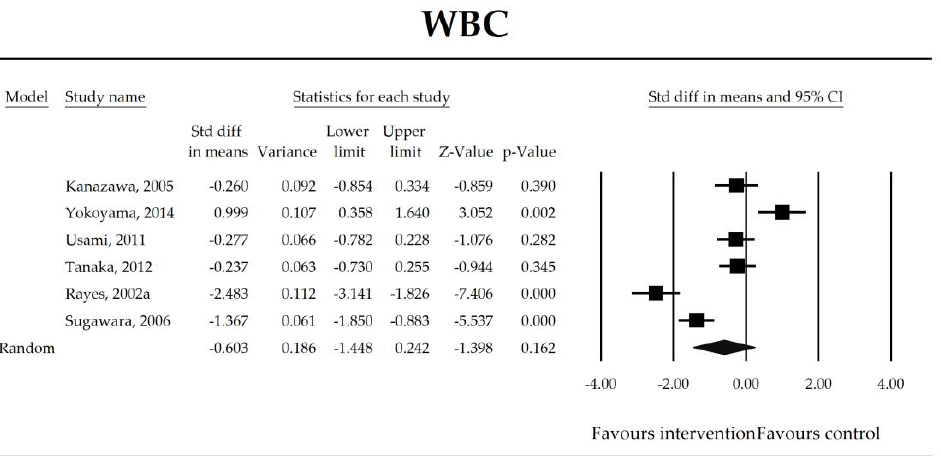
Figure 3. The effect size (standardized mean difference) for the concentration of IL-6 in patients taking probiotics (intervention) vs. no probiotics (control).